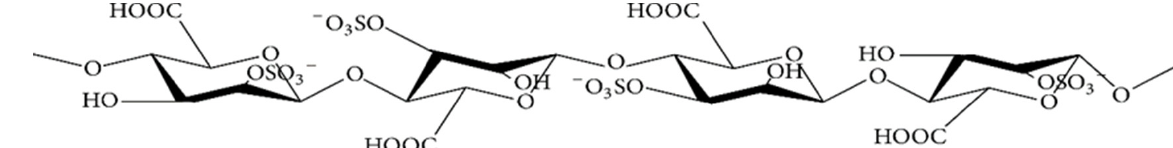
Figure 1. The structure of the alginate.